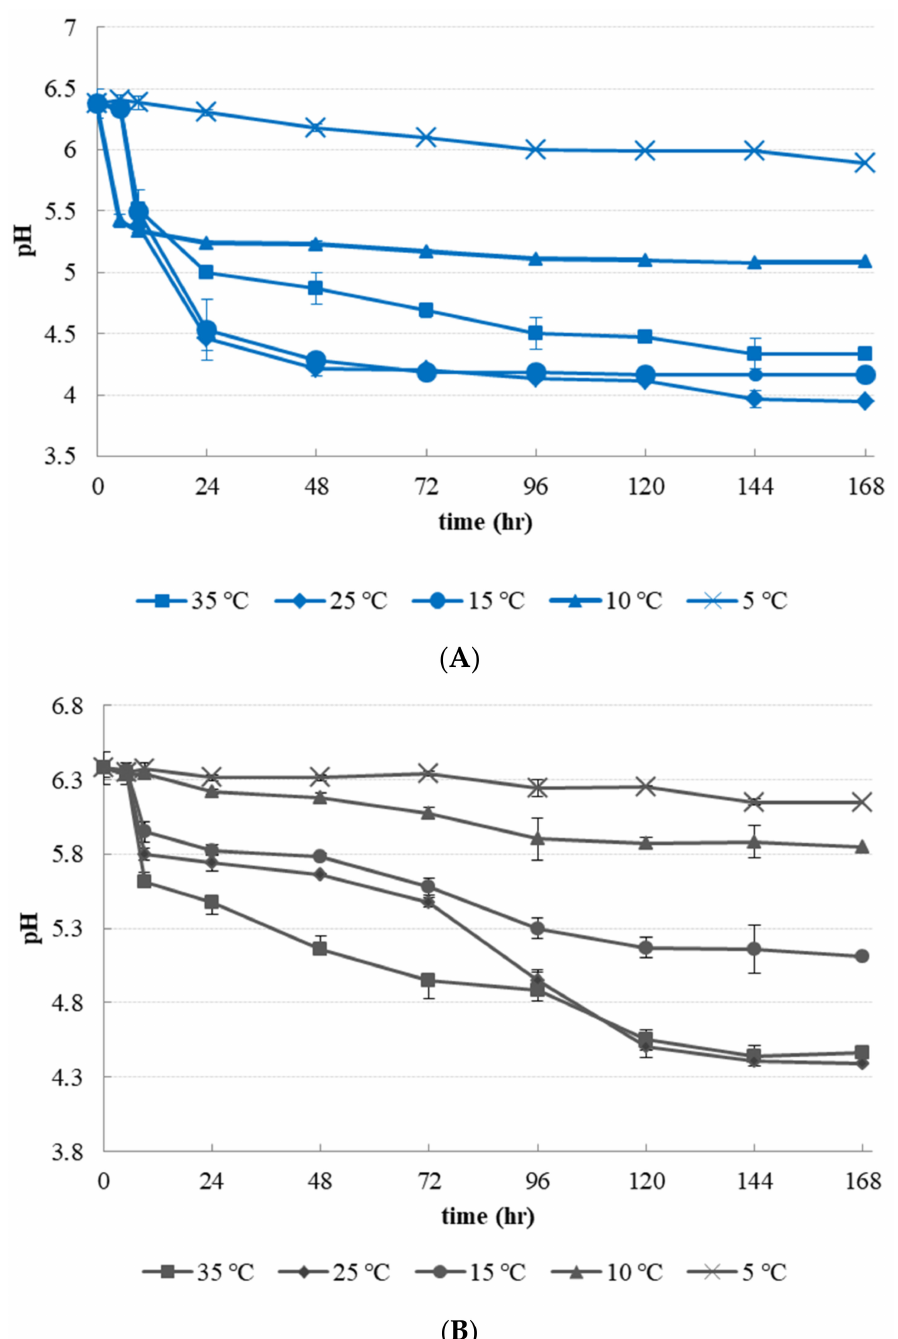
Figure 3. Change of pH values of Latilactobacillus curvatus PD1 and Leuconostoc mesenteroides PD2 at different temperature conditions in MRS broth with lactose (2%, w/v ) for 7 days: ( A ) Lactobacillus curvatus PD1 ( B ) Leuconostoc mesenteroides